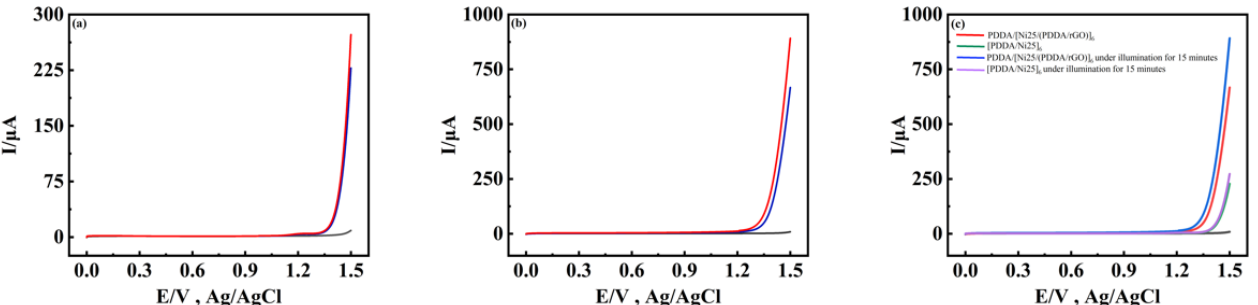
Figure 8. The comparison of the photoelectrocatalytic water oxidation of the composite films [PDDA/Ni25] 6 ( a ), PDDA/[Ni25/(PDDA − rGO)] 6 ( b ), and the combination of ( a , b ) ( c ). The blue curves represent the electrocatalytic water oxidation under dark conditions, red curves represent the electrocatalytic water oxidation under illumination for 15 min, the black curves represent the electrocatalytic water oxidation of bare ITO electrode, in 1 M NaAc + HAc (pH 6). Scan rate: 50 mV s − 1 . Table 1. IPCE of two films [PDDA/Ni25] 6 and PDDA/[Ni25/(PDDA–rGO)] 6